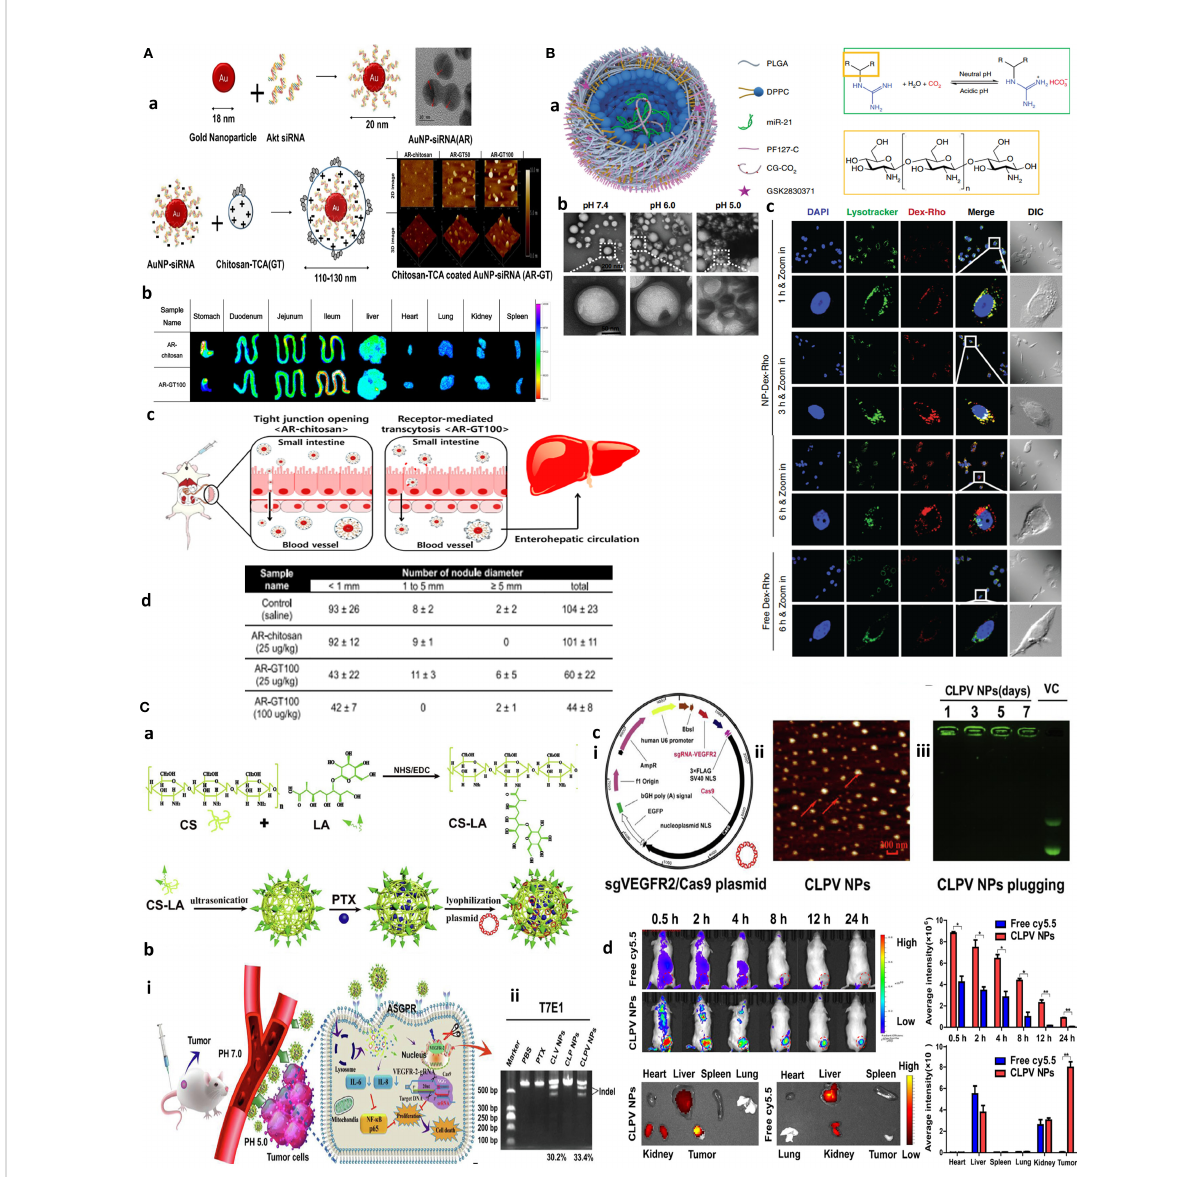
FIGURE 1 Chitosan NPs afford effective gene therapy and endo/lysosomal escape. (A) Bioinspired glycol chitosan NPs for GI passing and endosomal escape delivery of oral siRNA for successful treatment of CLM. (a) Synthesis and characterization of AR-GT NPs. (b) E x vivo fl uorescence images of major organs of the AR-coated chitosan and glycol chitosan (GC)-coated NPs in treated animals for 30 min. (c) In vivo mechanism of AR- GT100 transport, which is designed to occur through transcytosis, inspired from enterocytic-mediated recycling of amphipathic fatty acid bilirubin, with speci fi c accumulation in the ileum. For chitosan, this occurs through tight junctions. (d) Therapeutic ef fi cacy in a CLM cancer mouse model after oral delivery of AR-chitosan and AR-GT100 (25 or 100 m g/kg) and CLM lung antimetastatic potential. Reprinted with permission from (24), Copyright (2017), American Chemical Society. (B) Chitosan NPs for precisely targeting POLR2A as a therapeutic strategy for human triple-negative breast cancer. (a) Scheme for NP synthesis. (b) TEM images showing pH-responsive NPs and nanobomb effect that occur under low pH 5.0 – 6.0 endolysosomes, leading to NP enlargement and cracking. At the same time, spherical core – shell NPs are intact under pH 7.4. (c) Endosomal escape of Dextran-Rhodamine (Dex-Rho) NPs. In early hours, the red color largely overlapped with LysoTracker green fl uorescence. After 6 h, this overlap is minimum, indicating successful endosomal escape of core – shell chitosan-loaded anti-Mir21 due to the nanobomb effect. Reprinted from (25) Under Creative commons Attribution License 4.0, Copyright (2018) Springer Nature. (C) pH- responsive chitosan-based nanocomplex for ef fi cient CRISPR/Cas9 gene-chemo synergistic HCC therapy. (a) Schematics of preparation and characterizations of CLPV NPs. (b) (i) Working principle of CLPV NPs for precise targeting of VEGFR2 and downstream tumorigenic pathways IL- 6/IL-8-NF- k B p65; (ii) T7E1 analysis of the VEGFR2 sgRNA sites on tumor tissues. (c) (i) Plasmid pro fi le of recombinant sgVEGFR2/Cas9 (VC); (ii) AFM image of 238.2-nm CLPV NPs; (iii) agarose gel electrophoresis analysis for VC stability on NPs. (d) In vivo biodistribution studies using injected free cy5.5 and cy5.5-loaded CLPV NPs recorded at different time points from the major organs and tumor tissues. Reprinted with permission from (26), Copyright (2018)